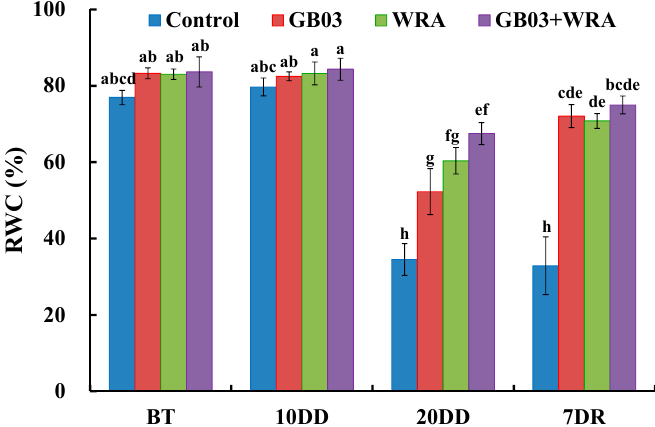
Figure 4. Effects of GB03, water retaining agent (WRA), or the combination of GB03+WRA on leaf relative water content (RWC) of ryegrass. BT, before treatment (20-day-old seedling); 10DD, 10-day natural drought; 20DD, 20-day natural drought; 7DR, 7 days after rewatering. Values are means and bars indicate SEs ( n = 12). Columns with different letters indicate significant differences among treatments at p < 0.05 (ANOVA and Duncan’s post-hoc multiple comparison test).